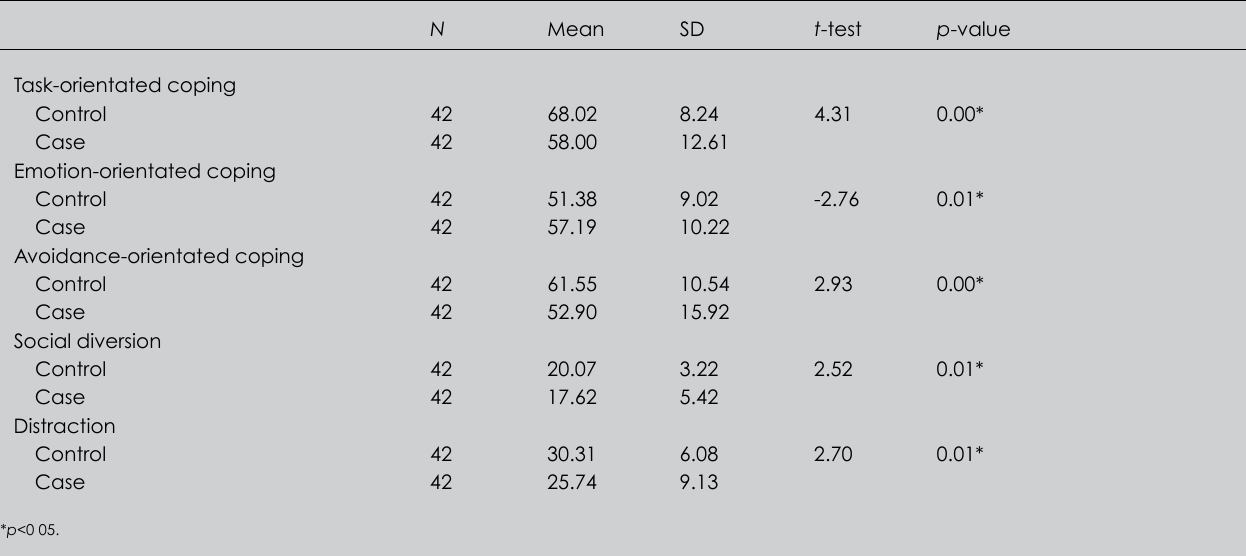
Table V. Comparison of coping skills between DSH patients and controls